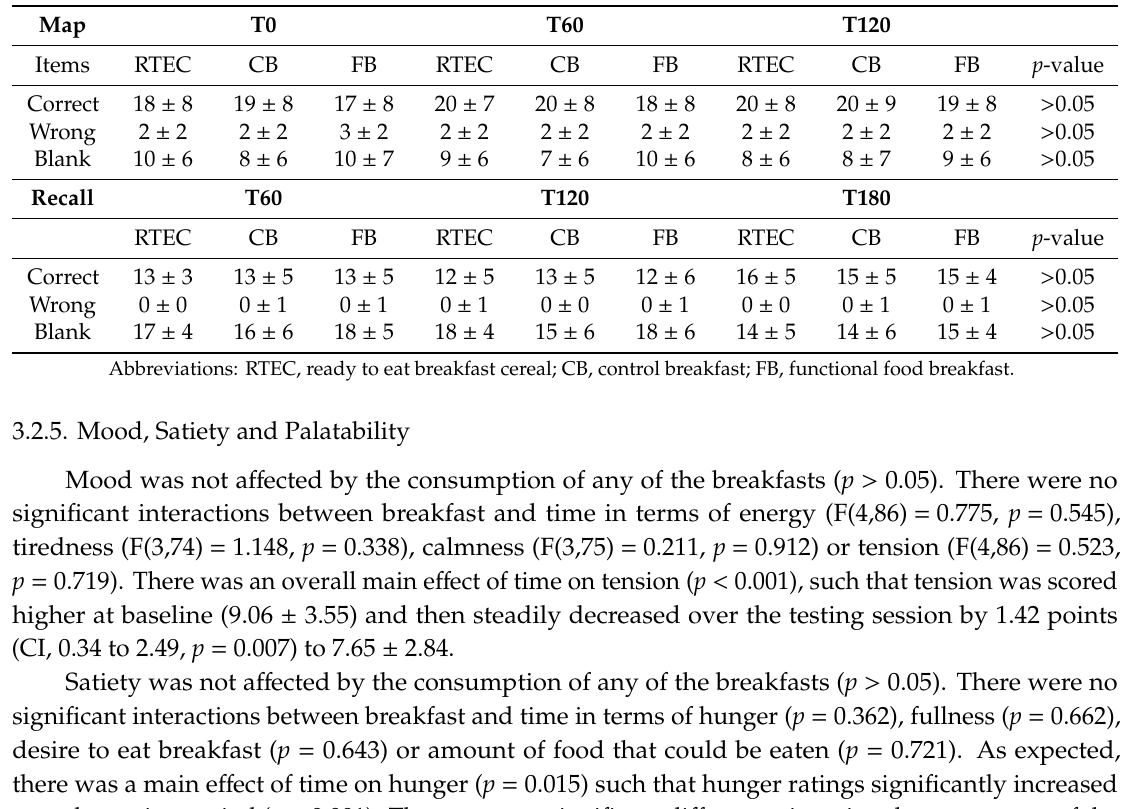
Table 2. Mean scores ± SD for map task (T0, T60 and T120; top table) and delayed recall task (T60, T120 and T180; bottom table) following consumption of RTEC, CB and